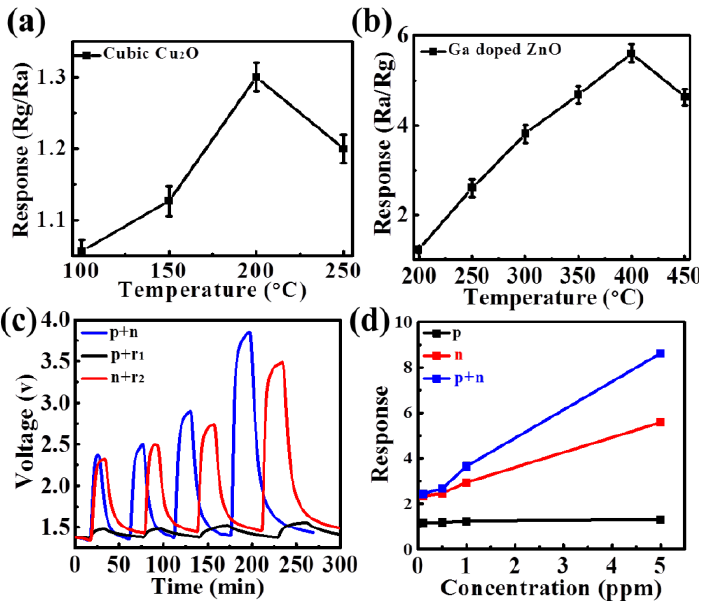
Figure 4. ( a ) Response of Cu 2 O p-sensor to 5 ppm ethanol at different working temperatures; ( b ) response of Ga-ZnO n-sensor to 5 ppm ethanol at different working temperatures; ( c ) responses of Ga-ZnO n-sensor, Cu 2 O p-sensor, and p + n sensor array to 5 ppm ethanol; and ( d ) relationship of Ga-ZnO n-sensor, Cu 2 O p-sensor, and p + n sensor array responses with ethanol concentrations.